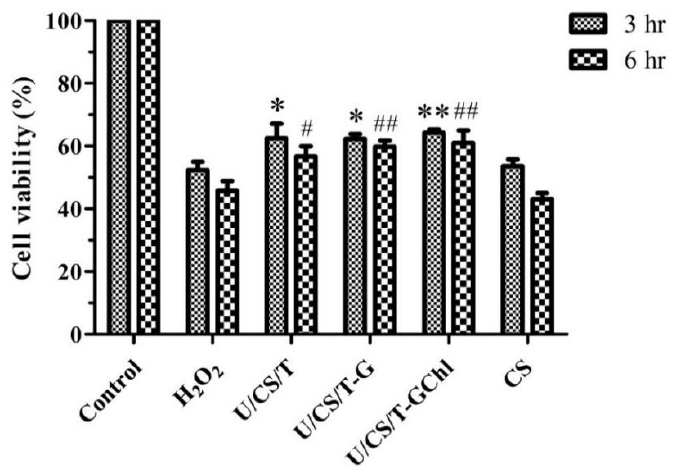
Figure 6. HaCaT cells were pre-cultured with the released media from the ulvan/chitosan complex films for 18 h prior to exposure to H 2 O 2 (200 µ M). Control is the medium without H 2 O 2 . * p < 0.05, ** p < 0.01 compared with the 3-hour H 2 O 2 group. # p < 0.05, ## p < 0.01 compared with the 6-hour H 2 O 2 group.